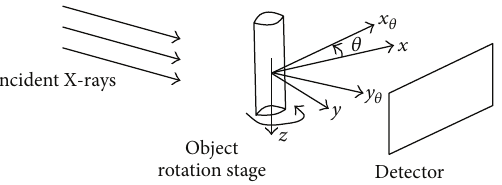
Figure 1: Experimental set-up in propagation based phase contrast tomography from a single propagation based phase contrast image per projection showing the coordinate